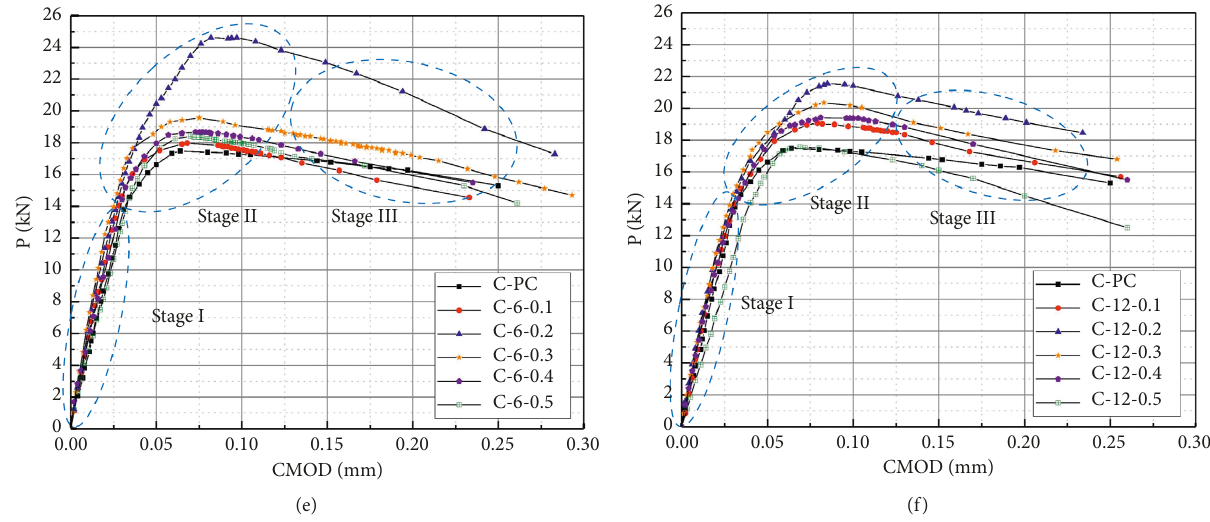
Figure 3: P-CMOD curves for 6mm and 12mm basalt fiber with various dosages. (a) Specimen A and fiber length 6 mm. (b) Specimen A and fiber length 12mm. (c) Specimen B and fiber length 6 mm. (d) Specimen B and fiber length 12 mm. (e) Specimen C and fiber length 6mm. (f) Specimen C and fiber length 12 mm.